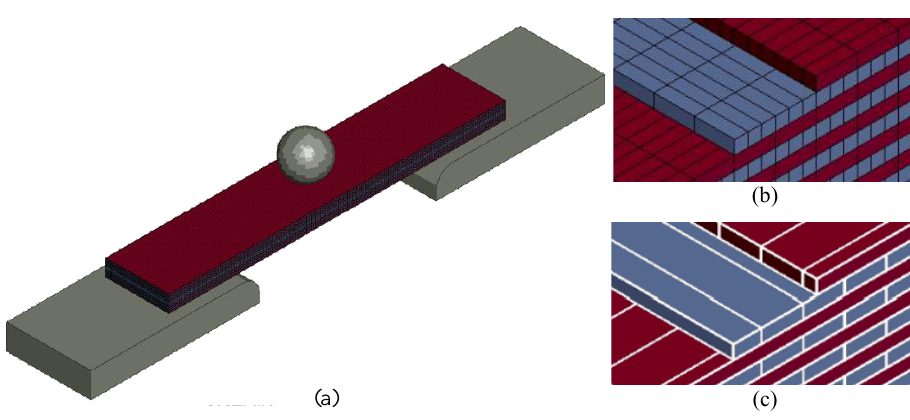
Fig. 3. Finite element model used for the dynamic three-point bending simulations (a); fibre-aligned ply-by-ply element mesh (b); and detached rows of elements along the fibre direction to simulate the transverse cracks form hygrothermal ageing damage